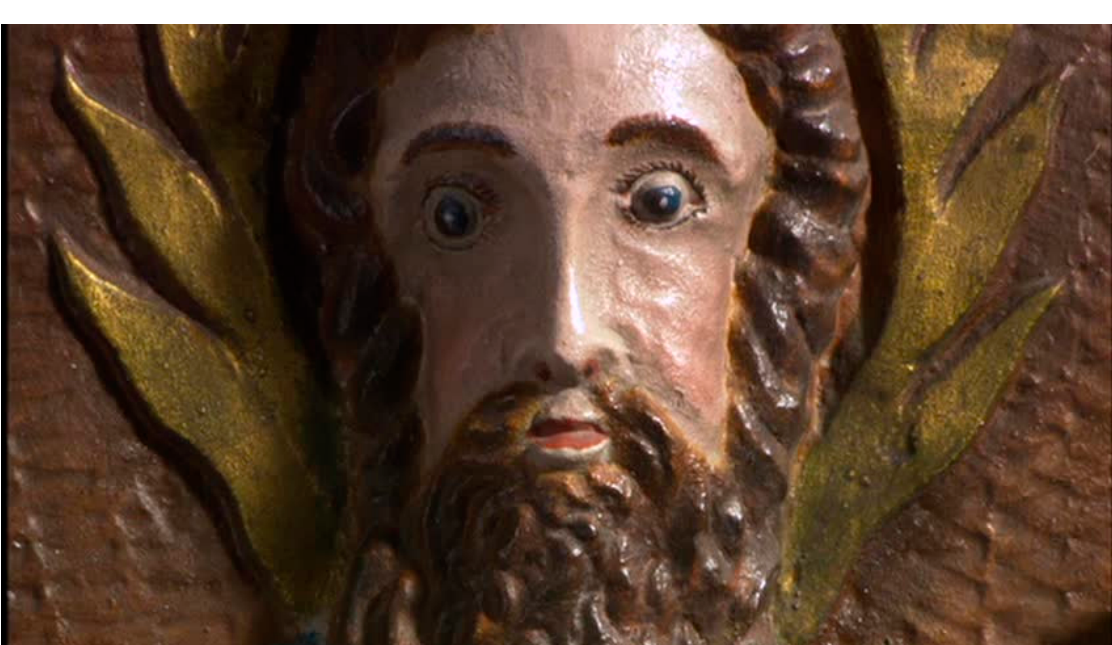
Figure 20. Light, Art, Prayer.